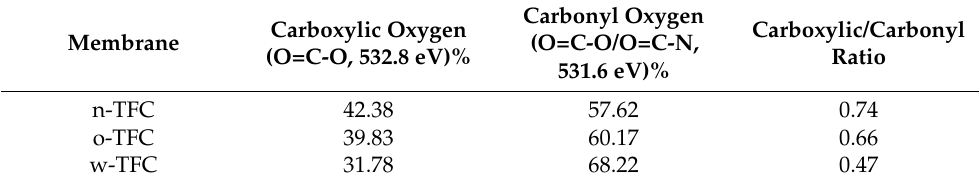
Table 3. Two curve-fitted peak components of high-resolution O 1s of nanofiber-supported PA layers